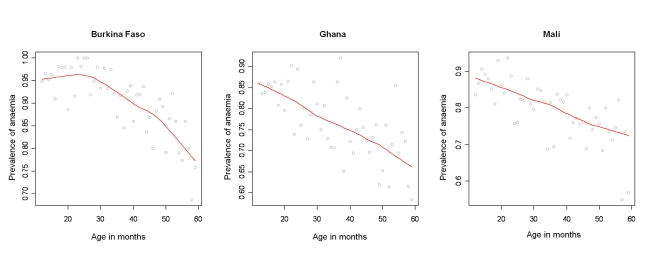
Profile of anaemia by age in Burkina Faso, Ghana, and Mali.Anaemia (y-axis; Hb<110 g/l) by age in months (x-axis; in months) with smooth fit line (red line) generated by a loess smoother, in children aged 1–4 y in the DHS surveys for Burkina Faso (2003), Ghana (2003), and Mali (2006).